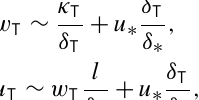
where Re t = w t d/ν , ρ p is the dust density, ρ is the air den- sity, g is the gravity acceleration, d is the size of